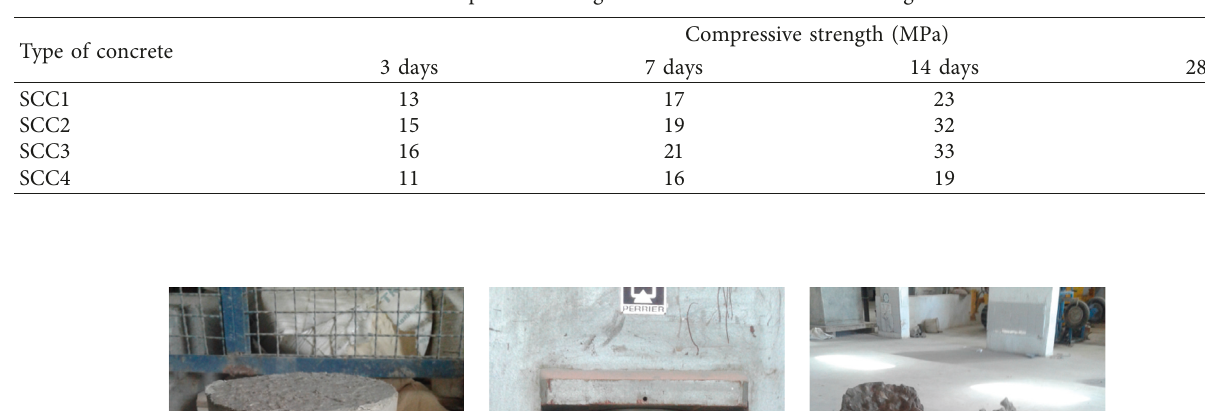
Table 8: Compressive strength of the four SCC at different ages.